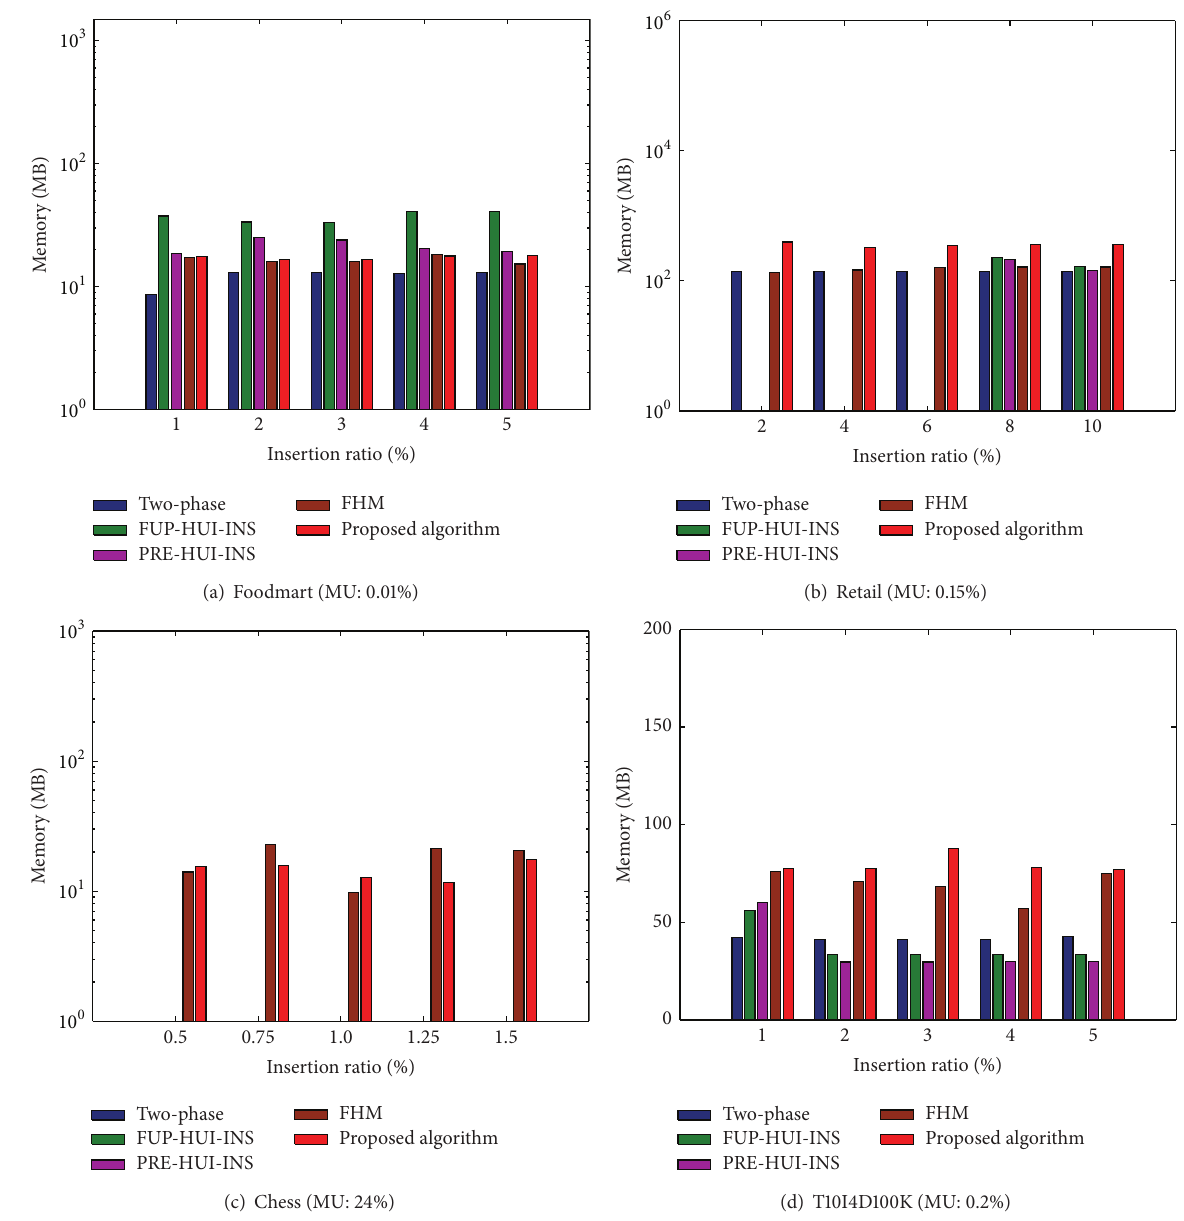
Figure 9: Memory consumption under various insertion ratios.